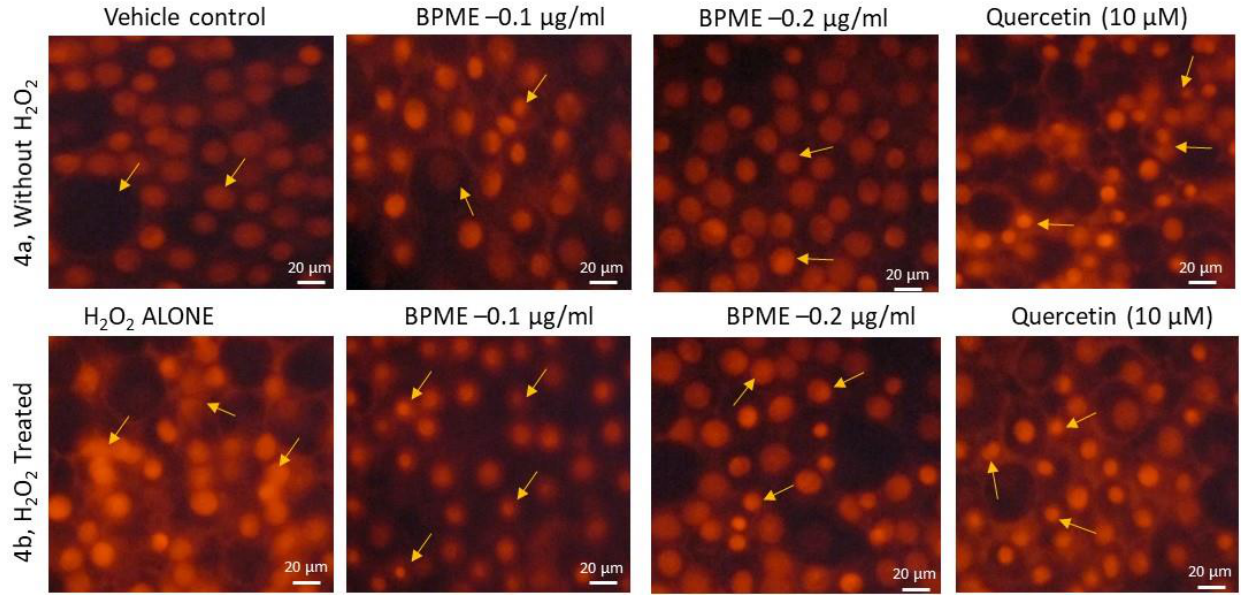
Figure 3. Analysis of microtube formation based on florescence microscopic in vehicle control, 0.1 and 0.2 µ g/mL dose of beetroot peel methanol extract (BPME) treated normal and H 2 O 2 -induced oxidative-stressed HUVECs after 48 h. After 48 h, H 2 O 2 -induced oxidative-stressed HUVECs showed altered morphology when compared to vehicle control. Volumes of 0.1 and 0.2 µ g/mL of beetroot peel methanol extract (BPME)-treated HUVECs showed normal morphology with vascular microtubules with proliferating cells resembling the common morphology of smooth muscle cell behaviour.